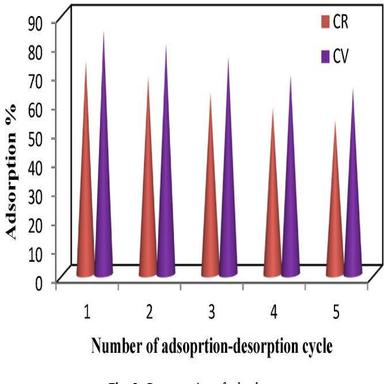
Regeneration of adsorbent.